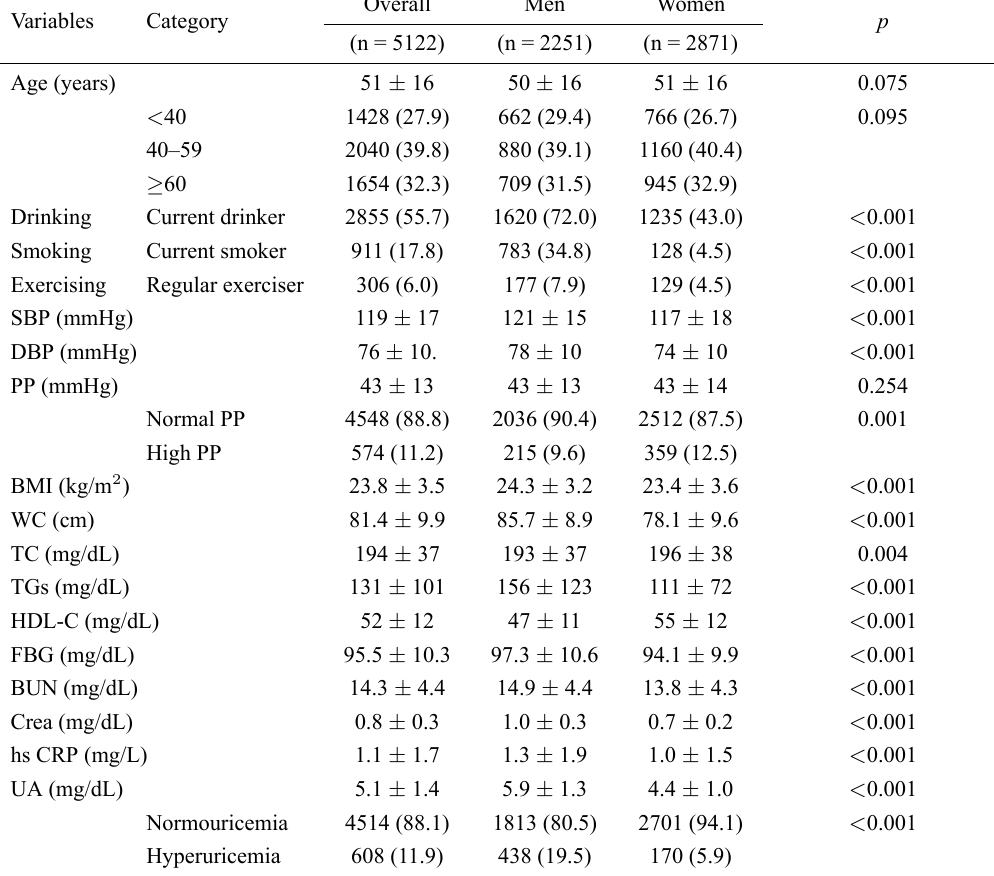
Table 1. General clinical characteristics (n (%), Mean ±